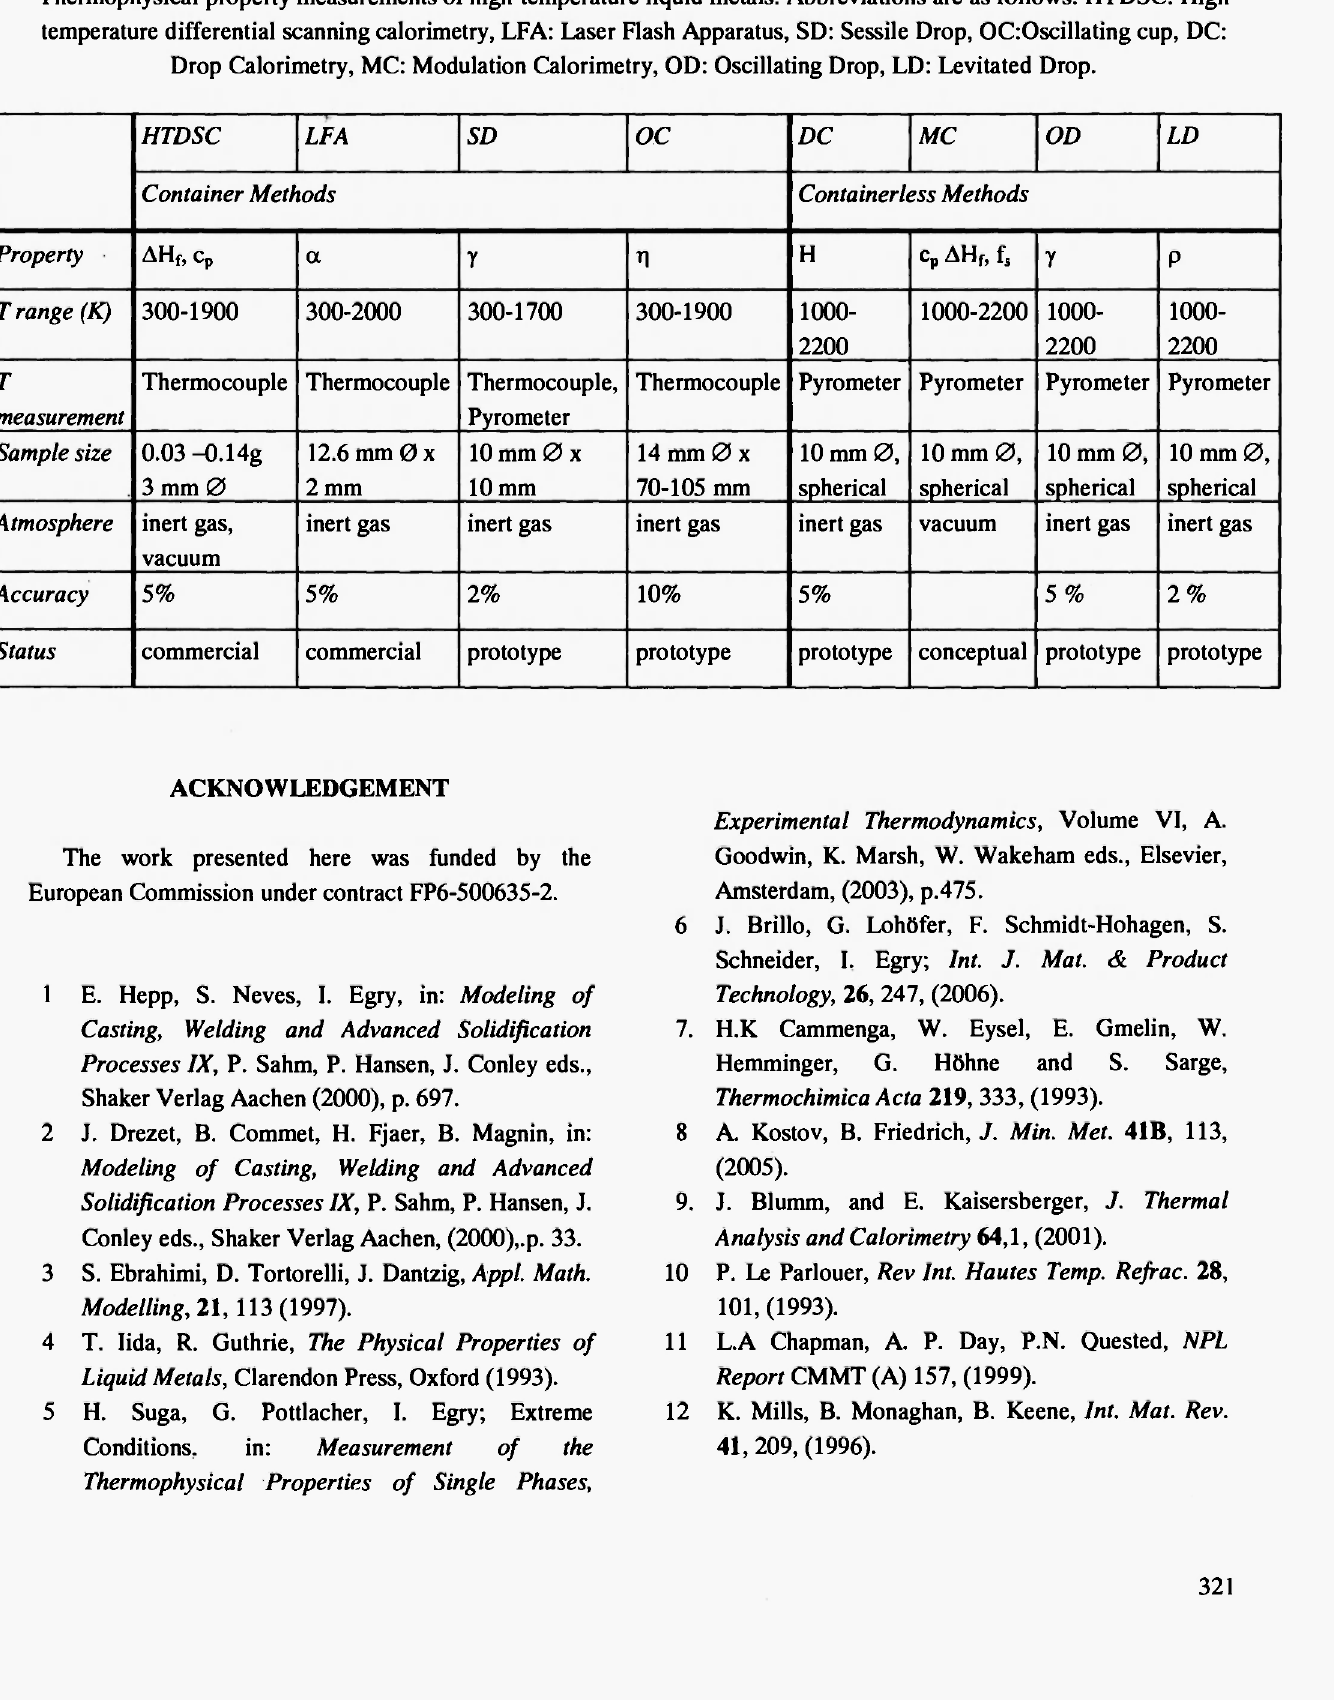
Thermophysical property measurements of high-temperature liquid metals. Abbreviations are as follows: HTDSC: